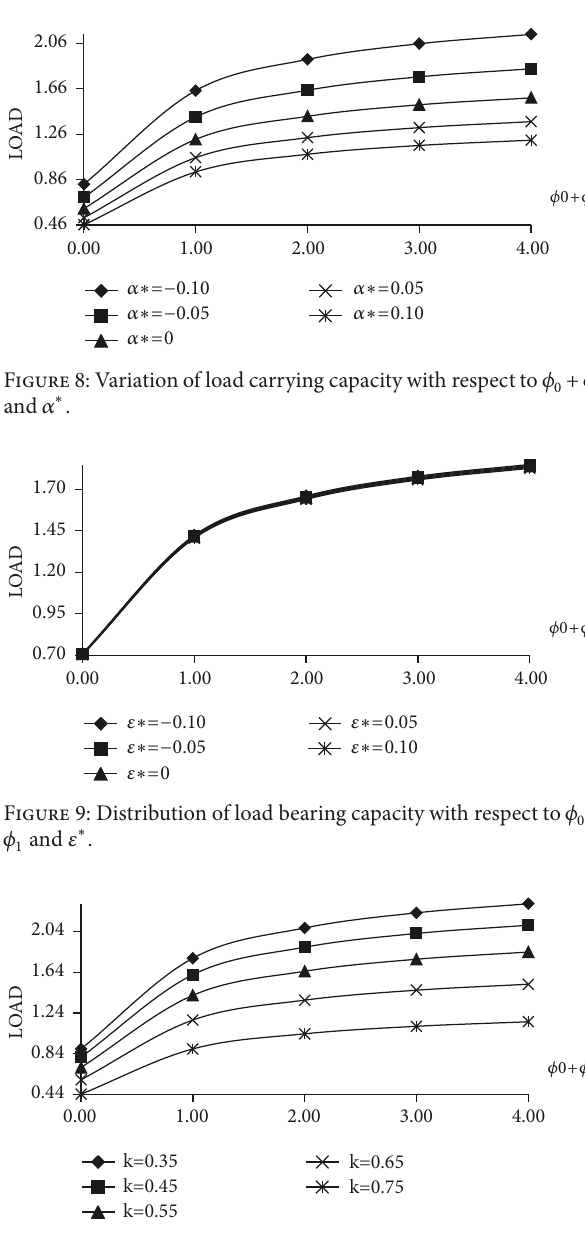
Figure 6: Distribution of load bearing capacity with respect to M and k.